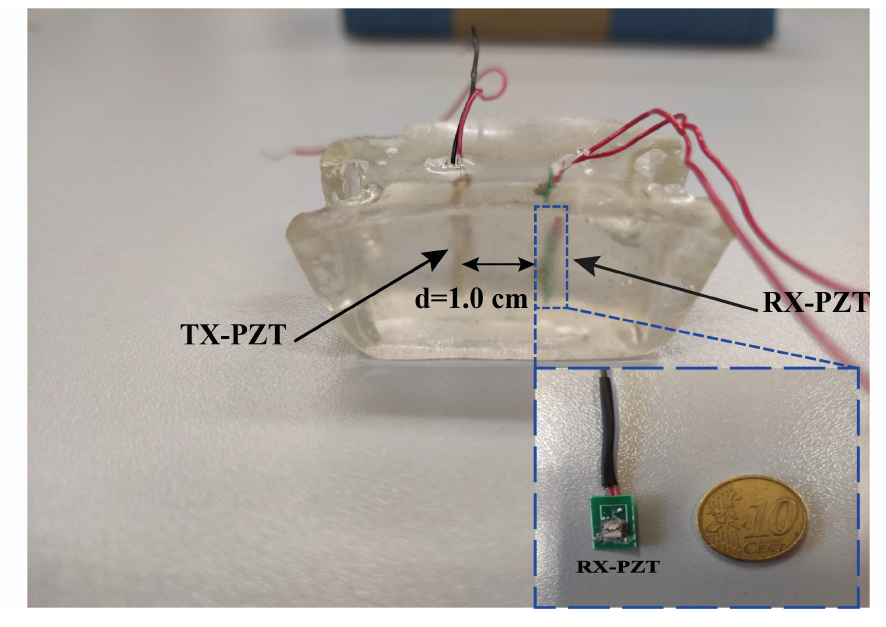
Figure 3. TX-PZT and RX-PZT encapsulated in ballistic gel at a distance of about 1.0 cm and the RX-PZT device compared to a 10 cent coin.